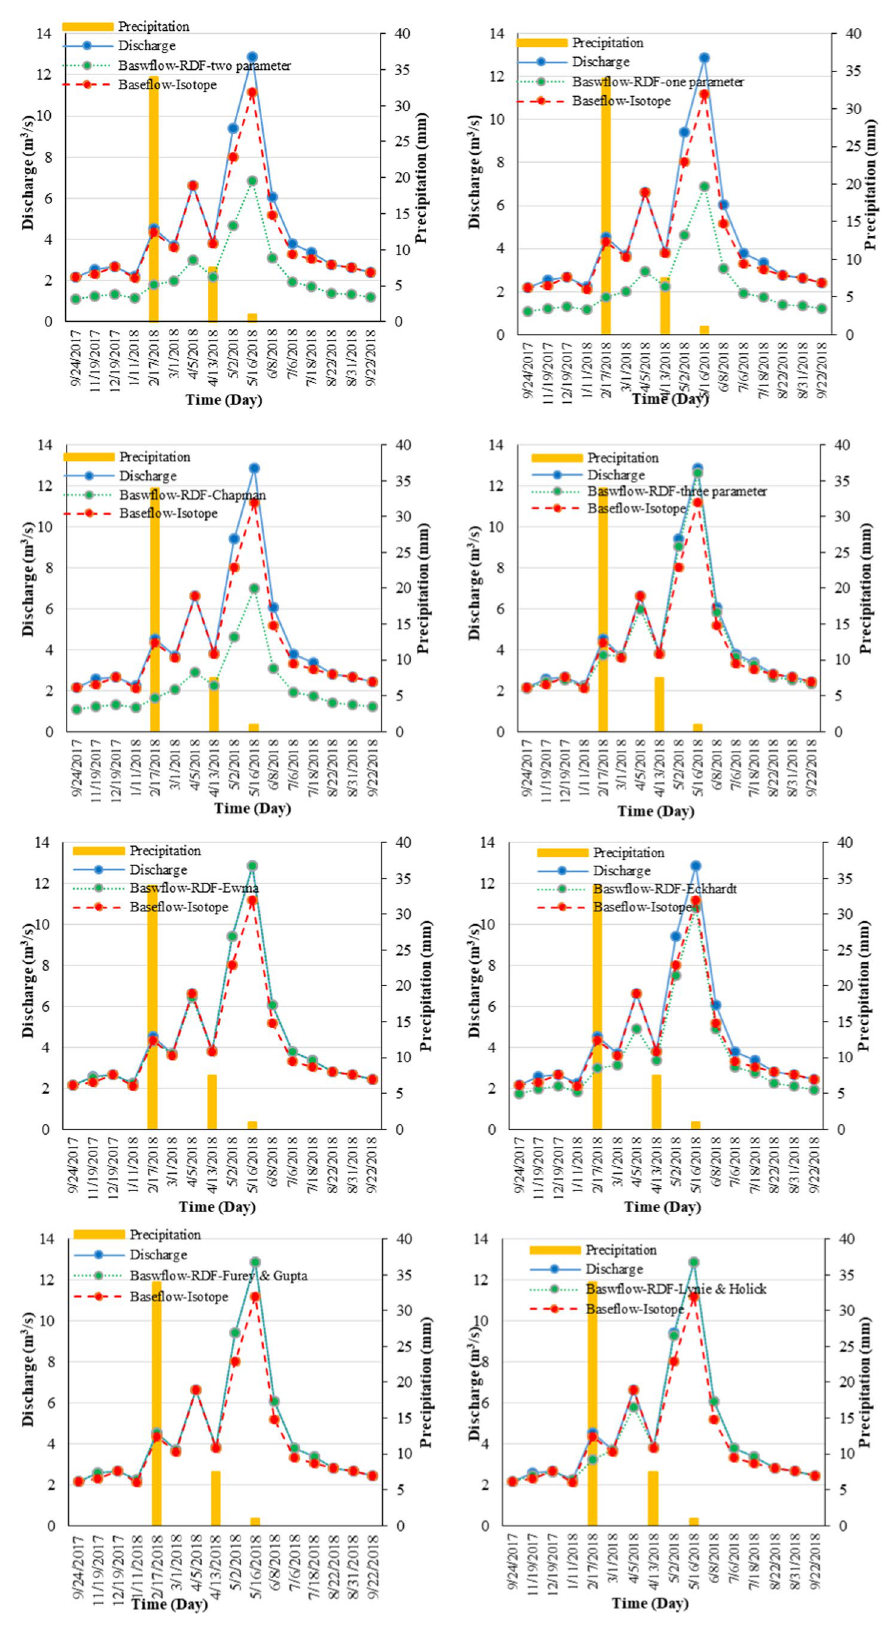
Fig. 6 Comparison of different algorithms of RDF method with isotope content O